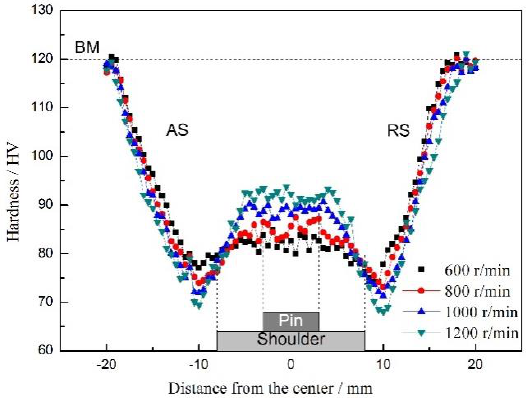
Figure 10. Microhardness distribution of the joints welded at different rotational speeds.